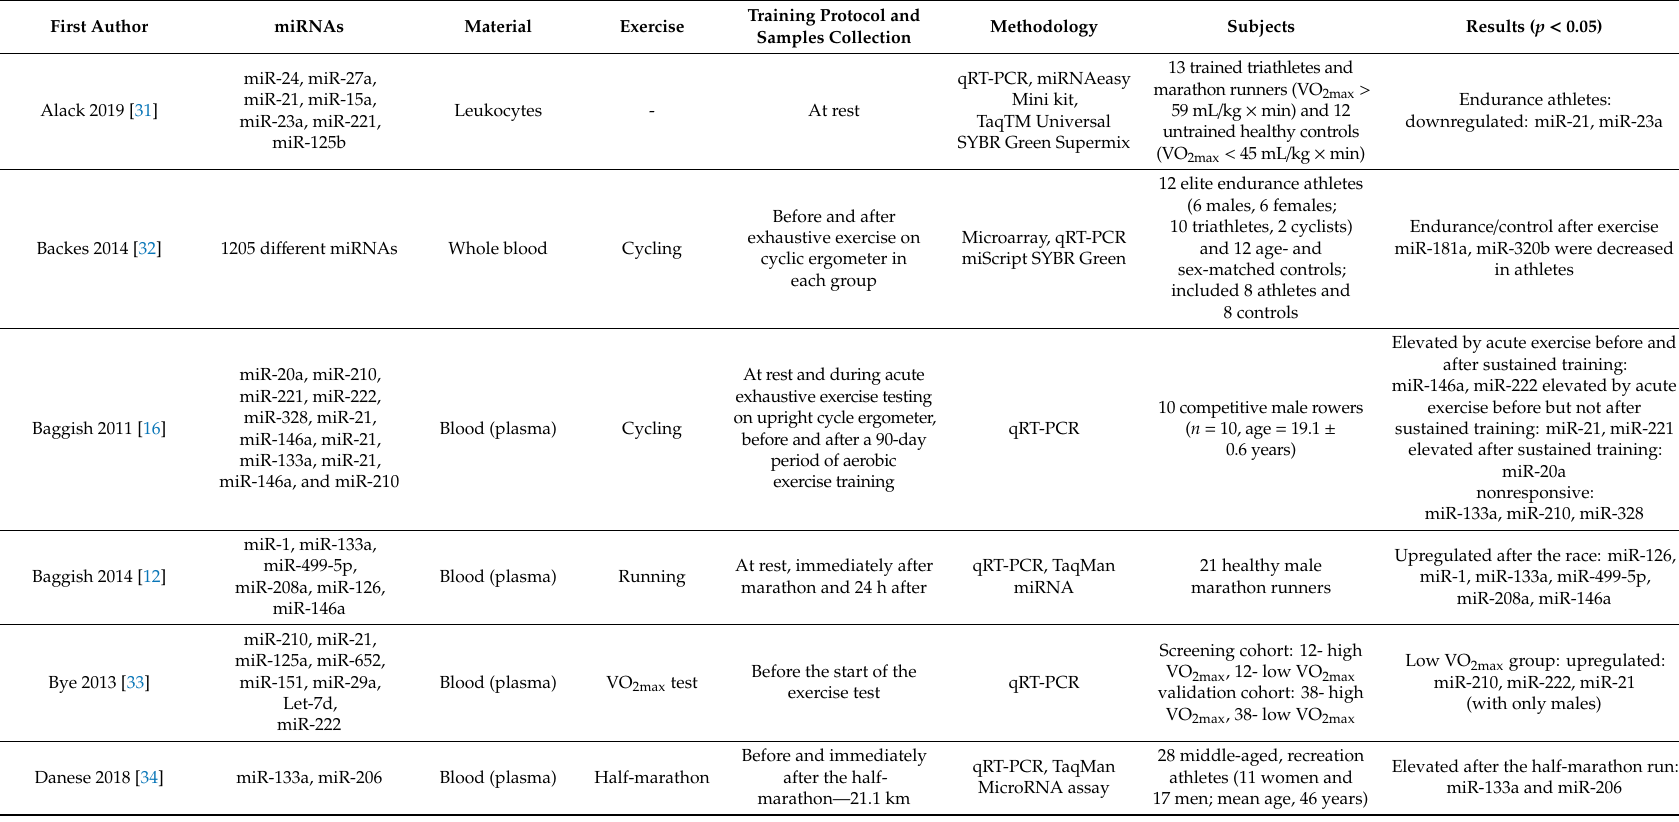
Table 1. Characteristics of microRNA studied in endurance